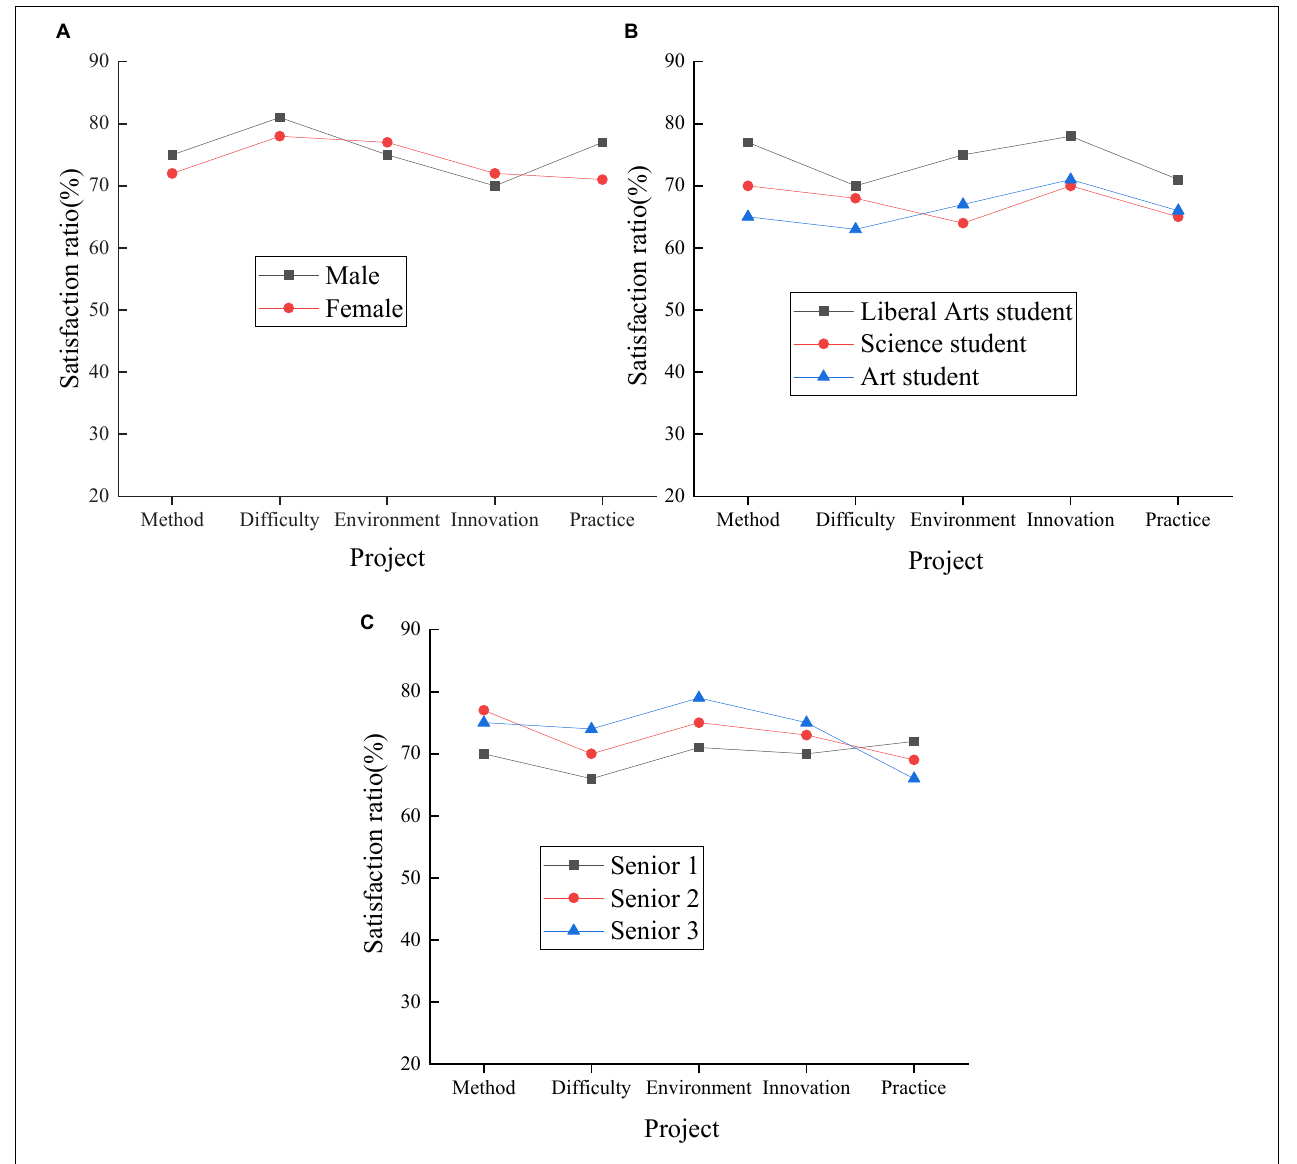
FIGURE 4 | Influence mechanism of Science, Technology, Engineering, Art, and Mathematics (STEAM) education model (Panel A: gender classification, Panel B: learning direction classification, Panel C: grade classification).